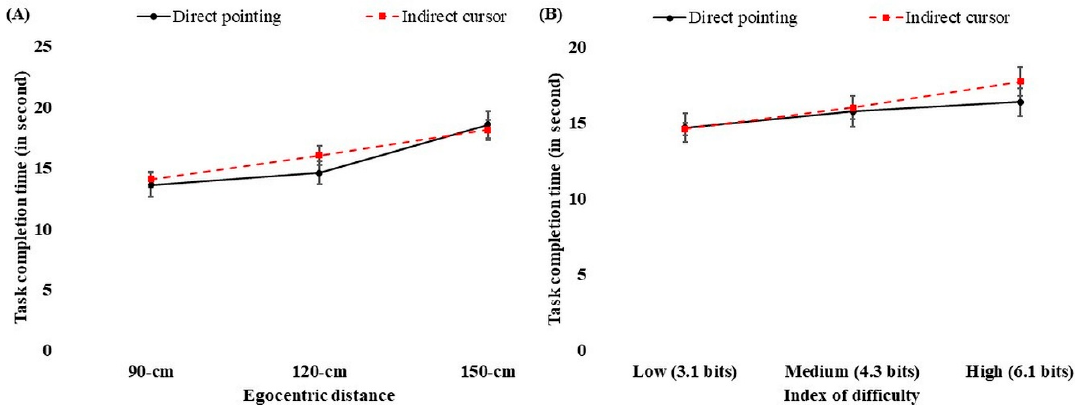
Figure 5. Results of task completion time for direct pointing and indirect cursor interaction techniques with respect to egocentric distance ( A ) and index of difficulty ( B ). The error bar represents standard error of mean.